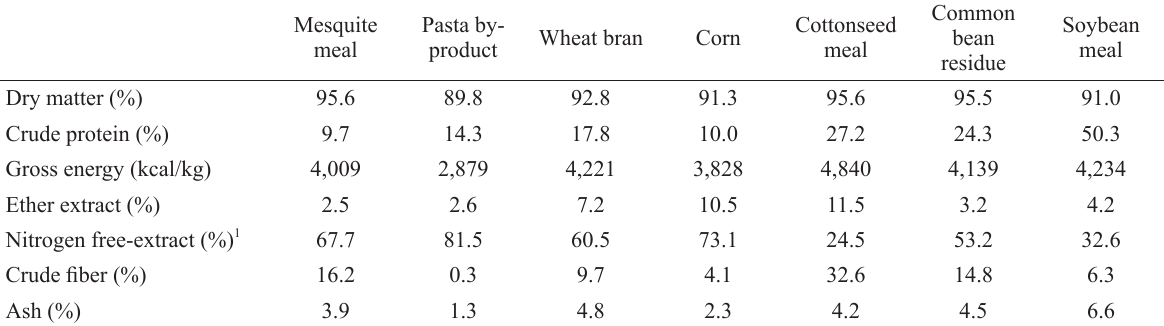
Chemical composition (dry matter basis) of evaluated ingredients.